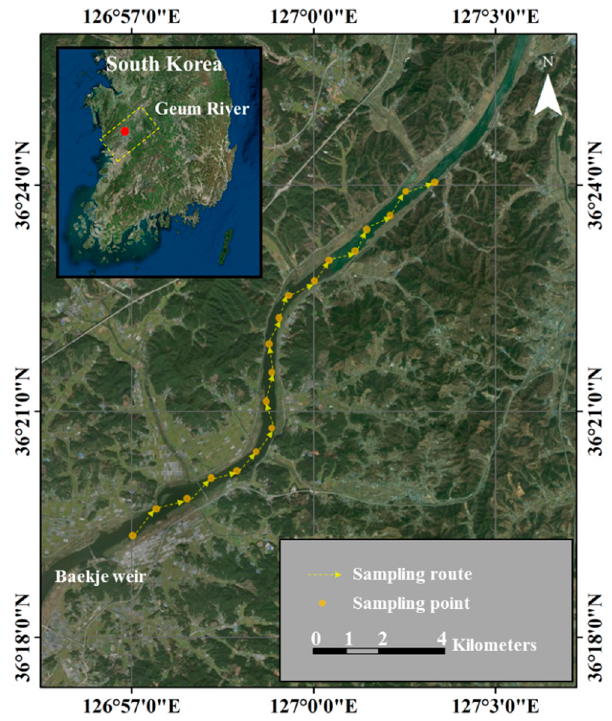
Figure 1. Study area, Baekje Weir in Geum River, with sampling route. The sampling points were mainly assigned in river side. Map showing location of Baekje Weir region (Google Earth, earth.google.com/web/).